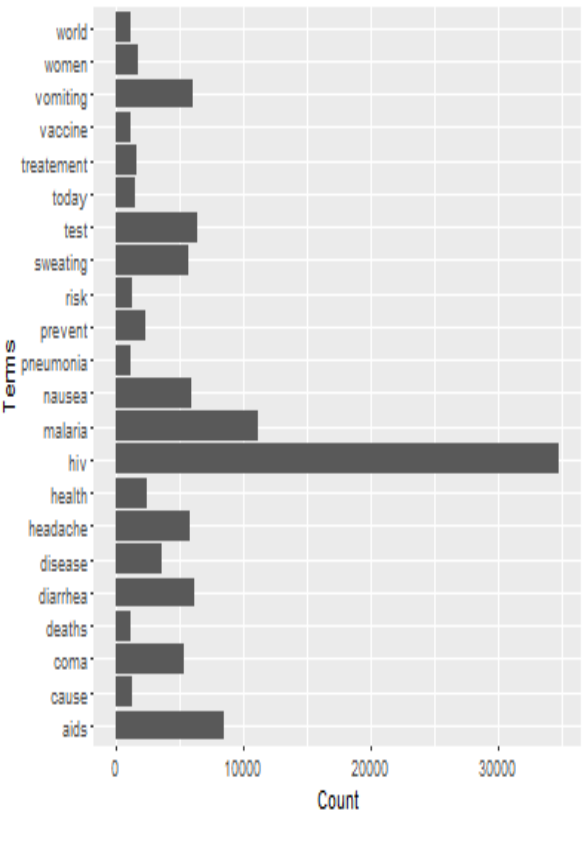
Figure 2 . Health-related Term Frequency for common words and corresponding Plot formation as histogram